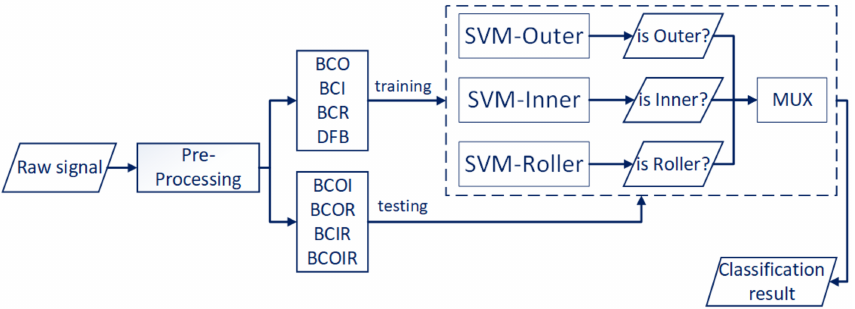
Figure 5. Set of support vector machines (SVMs) for